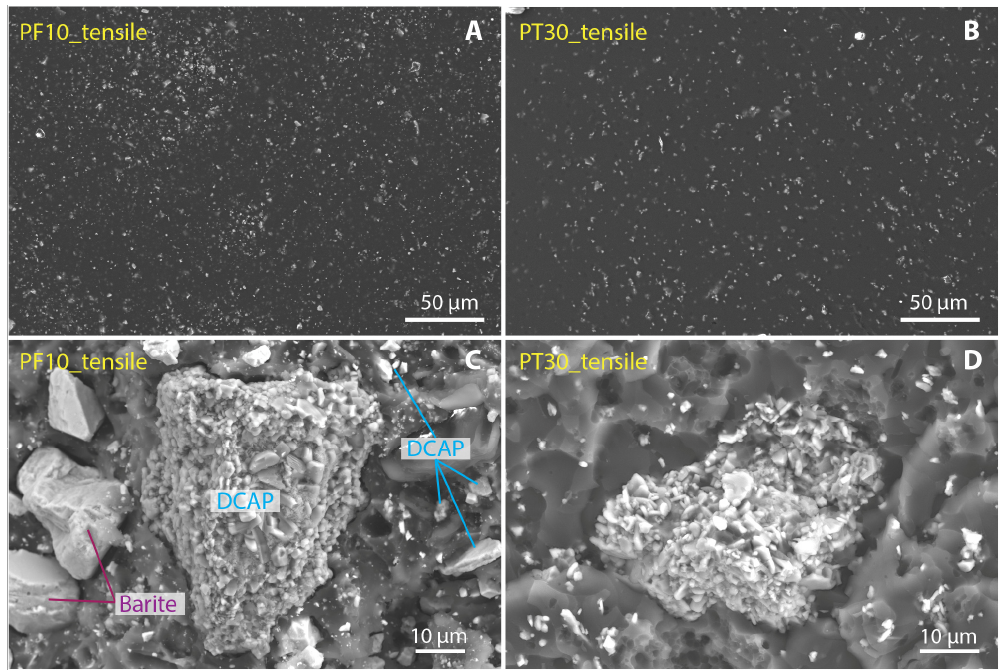
Figure 6. ( A , B ) SE images of the pristine external surface of the PF10 and PT30 samples, respectively. The bright spots are inorganic filler grains. ( C , D ) SE images of PF10 and PT30 samples, respectively, showing the typical shape and size of the inorganic filler. The DCAP is present either as individual micro-to-nano particles (highlighted by blue lines in ( A )) or as aggregate up to several tens of microns in size. Barite shows a more homogeneous average grain size compared to DCAP, in agreement with DLS data (Figure